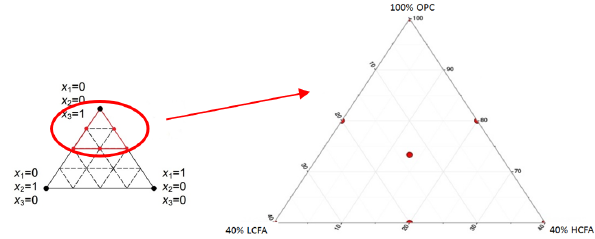
Figure 2: Plan of cement mortar